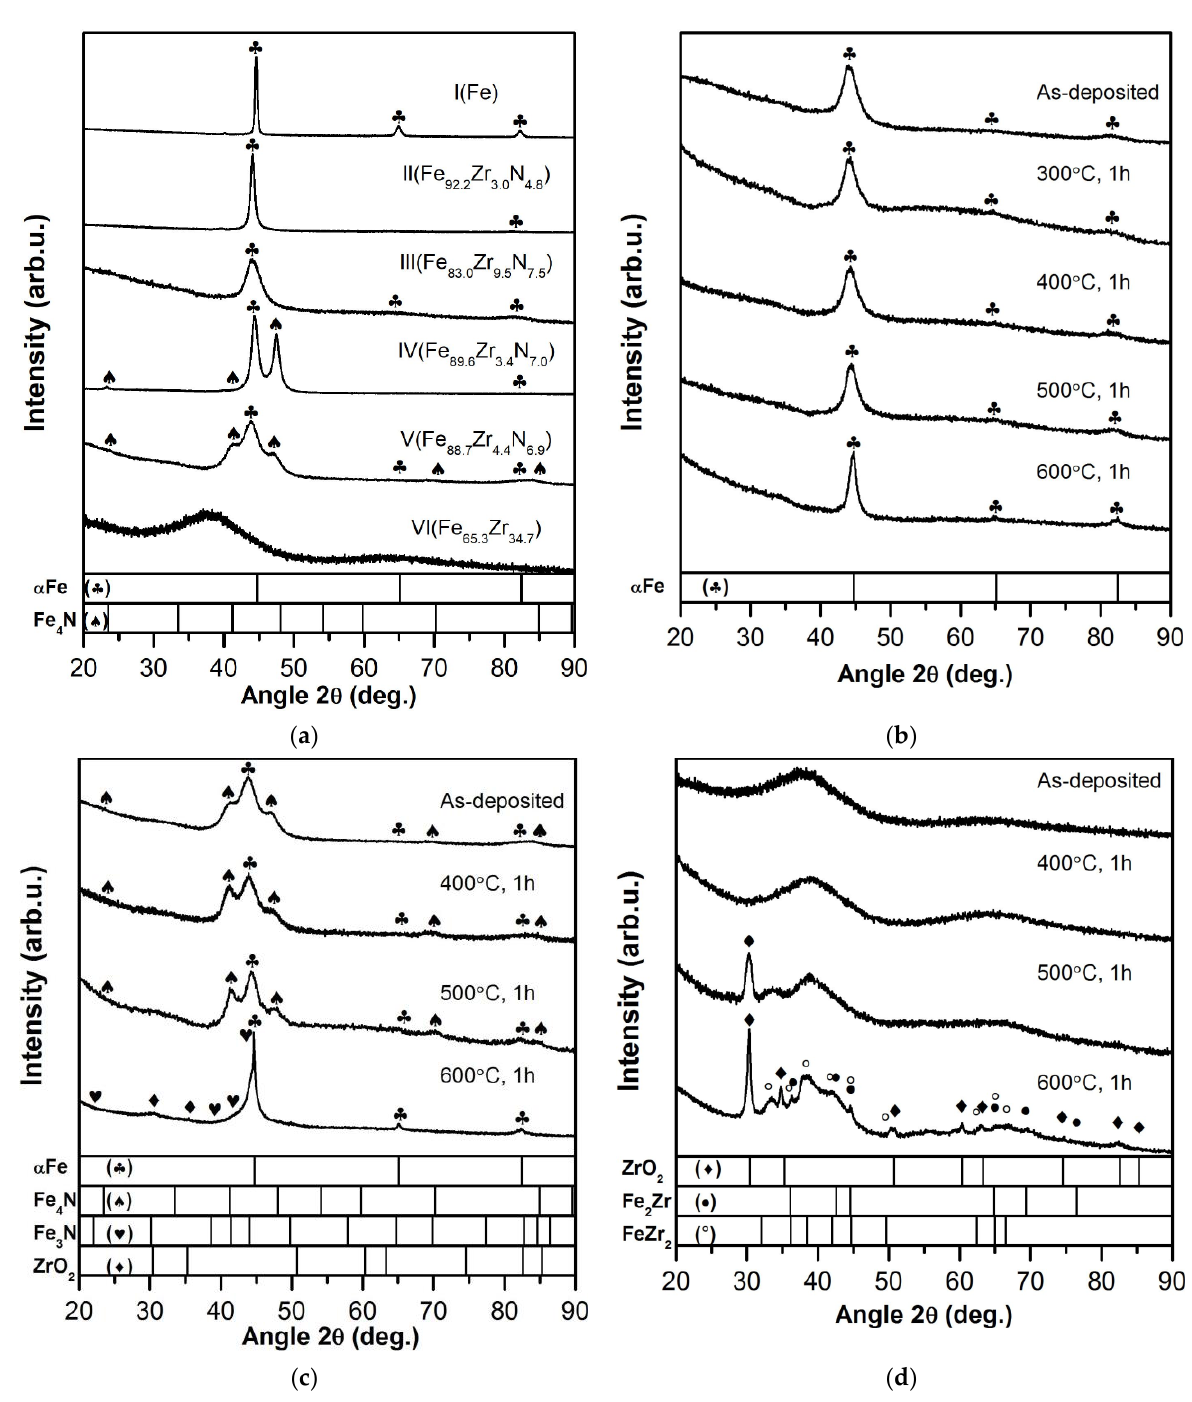
Figure 3. The XRD patterns of the as-deposited films ( a ) and films III ( b ), V ( c ), VI ( d ) after anneal- ing.